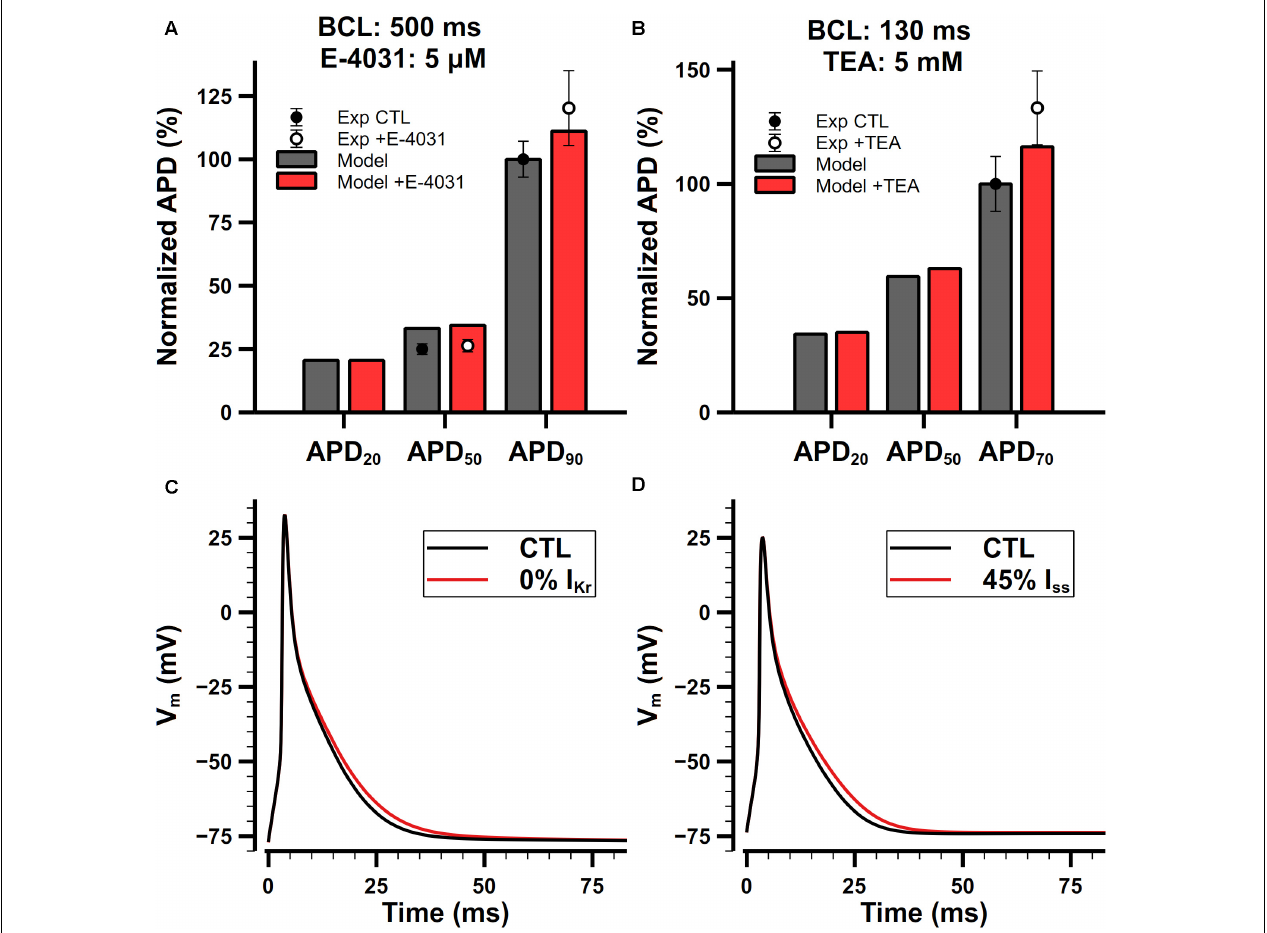
FIGURE 14 | Role of I Kr and I ss in the mouse atrial cell model. (Ai,Aii) Comparison of normalized APDs with experimental data (Ai) and simulated APs (Aii) before and after the application of 5- µ M E-4031. The cell was paced at 2 Hz. Experimental data was extracted from Nakamura et al. (2010). (Bi,Bii) Comparison of normalized APDs with experimental data (Bi) and simulated APs (Bii) before and after the application of 5-mM TEA. The CL of the pacing protocol was 130 ms. Experimental data was extracted from Nygren et al.